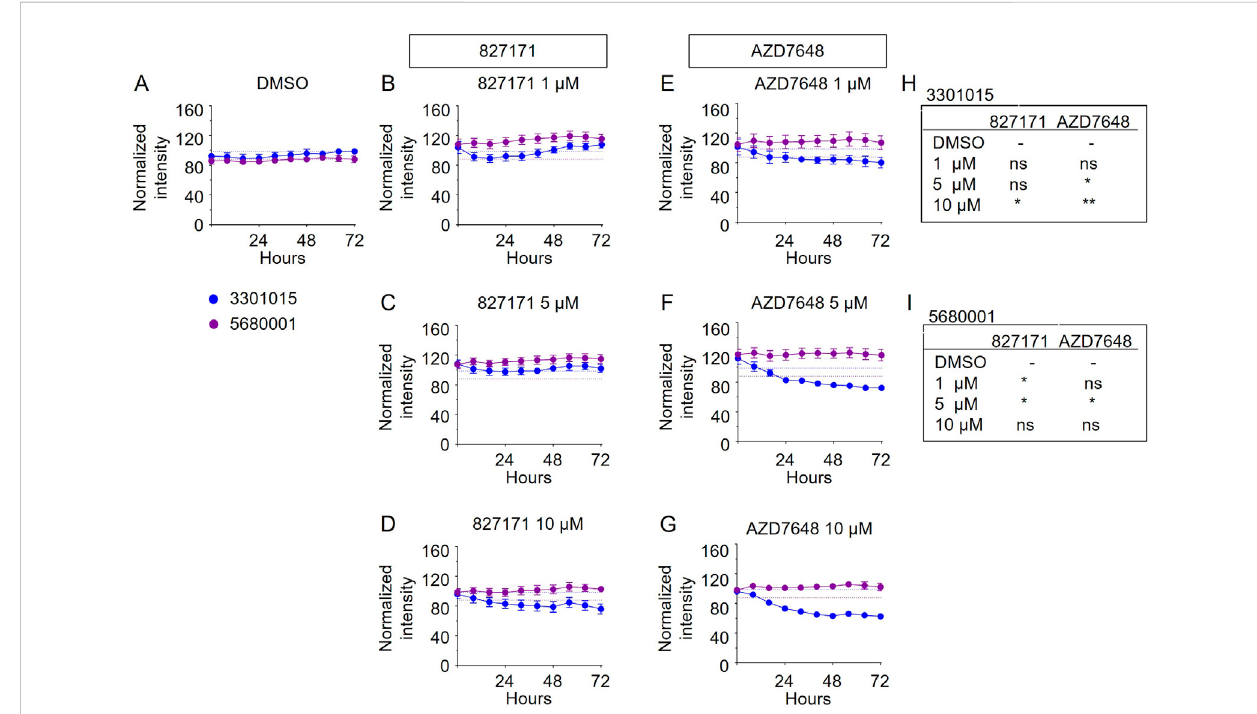
FIGURE 6 TheArtemisinhibitor827171andDNA-PKinhibitorAZD7648haveminimaleffectonmatureBcells.MatureBcelllines(3301015and5680001)were transduced with GFP, and 100,000 cells were plated in 24-well plates seeded with irradiated OP9 cells. Cells were treated with DMSO control (A) or Artemis inhibitor 827171 (B – D) or DNA-PK inhibitor AZD7648 (E – G) with the indicated doses. Green fl uorescence intensity was measured by Incucyte every 8 h. Raw values were normalized to the 0 h DMSO control. The dashed lines indicate the mean of the fi nal time point measurements of the DMSO control for each mature B cell line. The statistical analysis of proliferation differences is shown for the fi nal time point measurements for 3301015 (H) or5680001 (I) aftertreatmentwith827171orDNA-PKinhibitorAZD7648atindicateddosescomparedtoDMSOcontrol.ns:non-signi fi cant. * p < 0.05; ** p < 0.001; *** p < 0.0001, for statistically signi fi cant changes in proliferation of a treatment group compared to DMSO by one-way